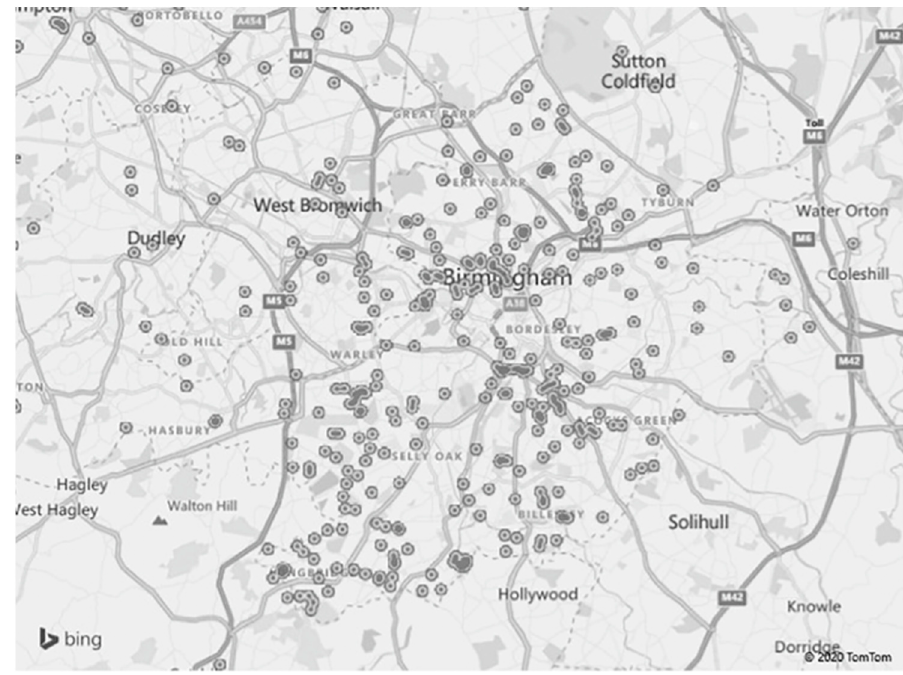
Figure 2. Heat map showing distribution of cases in Birmingham and surrounding areas.